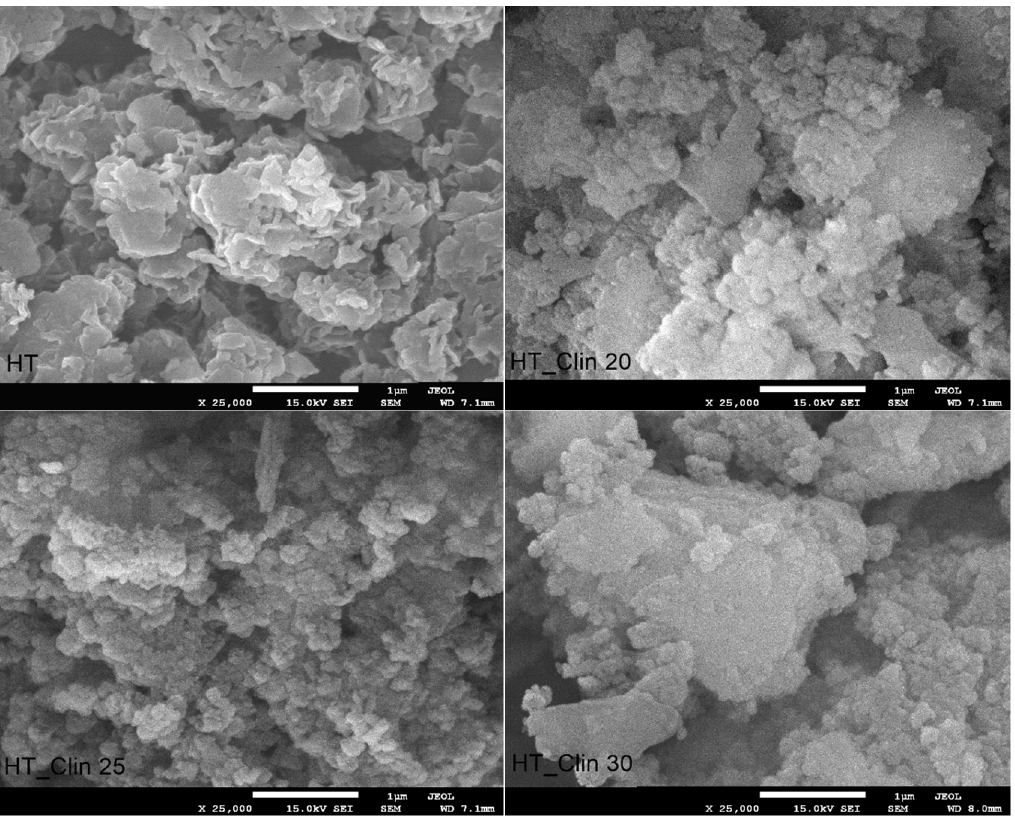
Figure 6. SEM images of non-supported hydrotalcite (HT) and clinoptilolite samples covered with hydrotalcite at different levels of coverage.